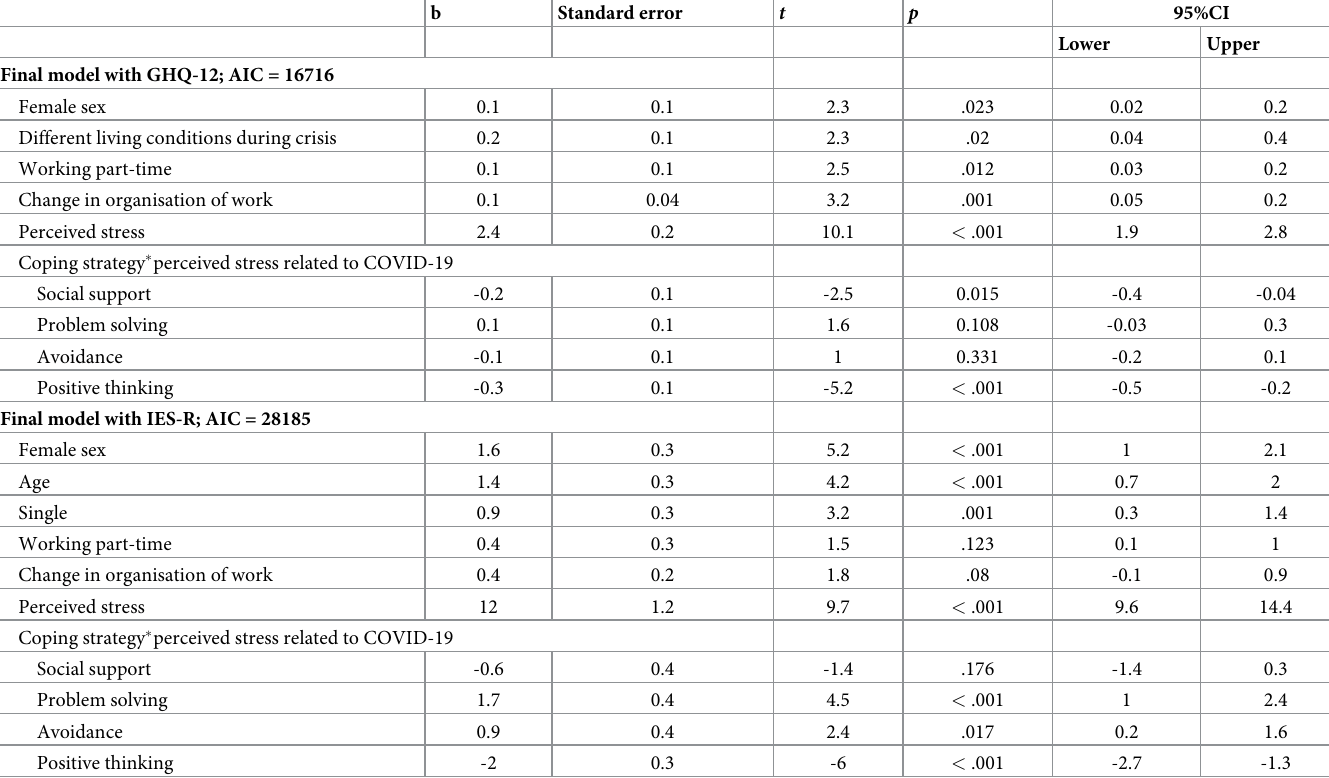
Table 3. Results of linear regression analyses for the severity of psychological distress and PTSD